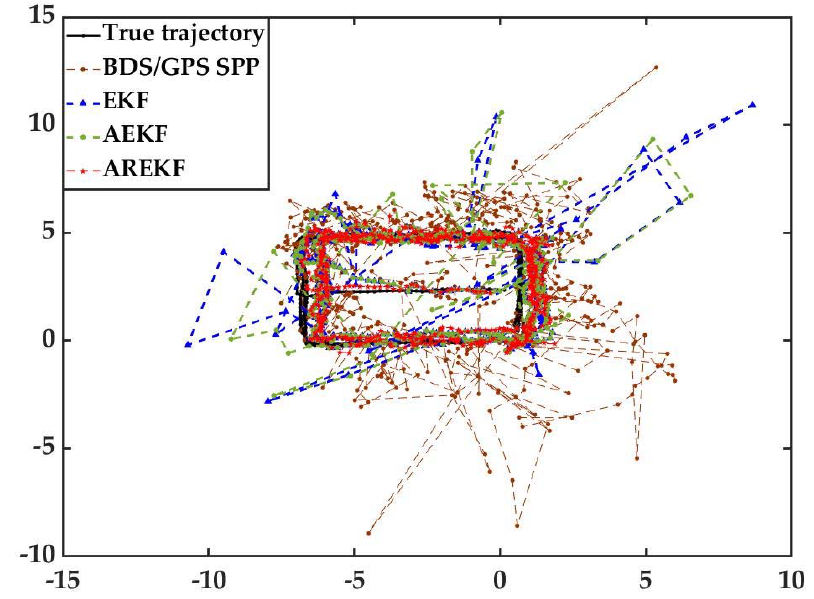
Figure 7. Pedestrian positioning trajectory in the transition area.